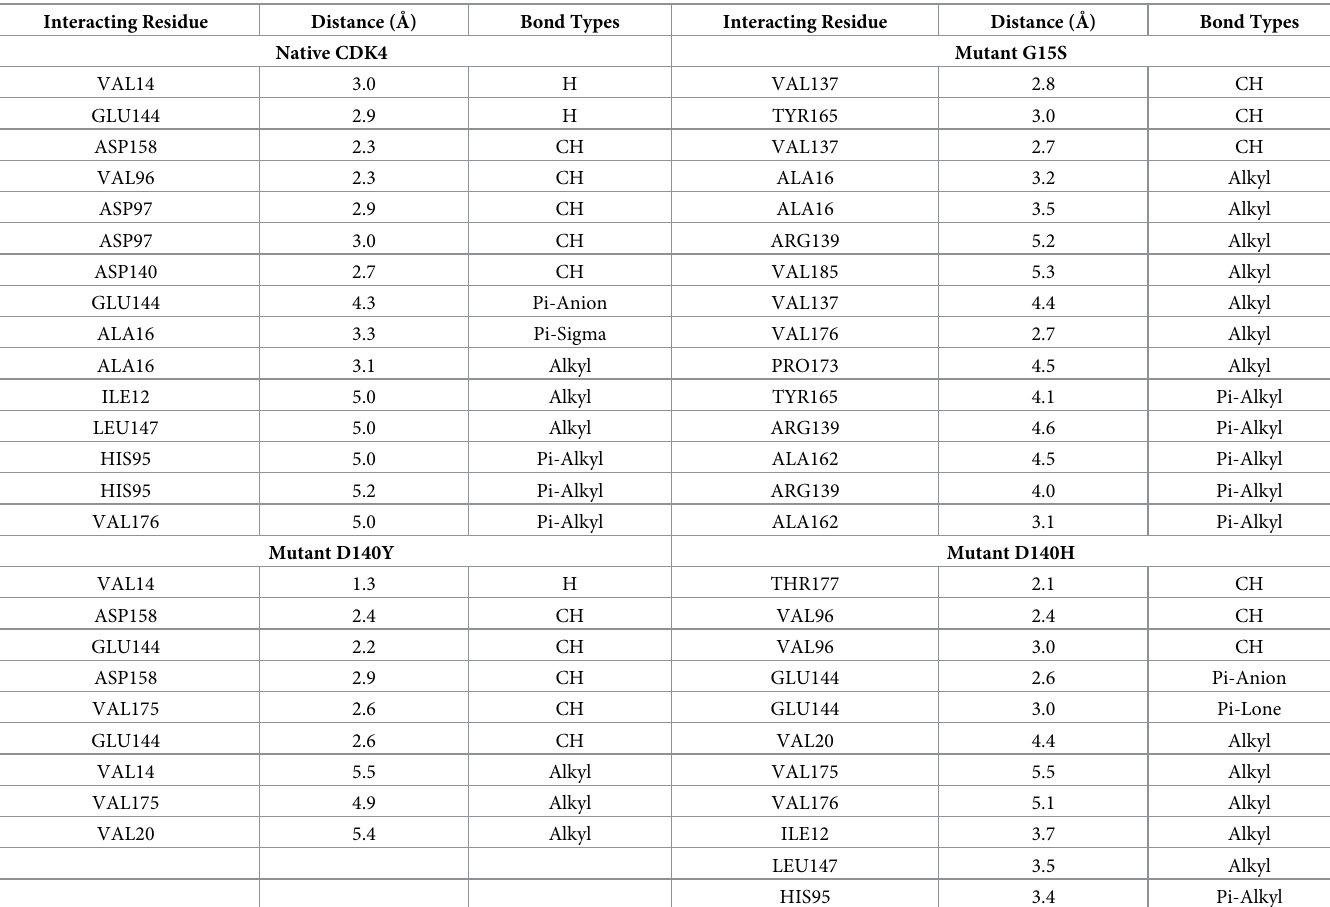
Table 2. Protein-ligand interaction analysis of native and mutant proteins with ribociclib (H = Hydrogen bond; CH = Carbon Hydrogen